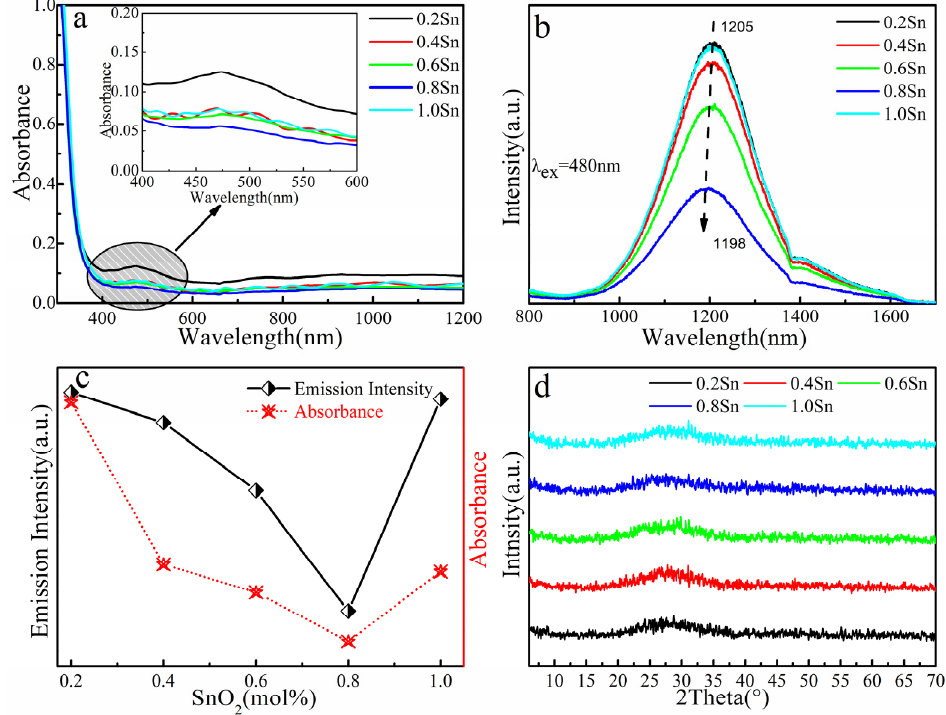
Figure 3. ( a ) Absorption spectra of (59.5-x) SiO 2 -10Al 2 O 3 -30CaO-0.5Bi 2 O 3 -xSnO 2 (x = 0.2, 0.4, 0.6, 0.8, 1.0) samples. The inset shows their absorbance in the range from 400 nm to 600 nm. ( b ) PL spectra of the (59.5-x) SiO 2 -10Al 2 O 3 -30CaO-0.5Bi 2 O 3 -xSnO 2 glass samples excited by a 480 nm LD. ( c ) Dependencies of emission intensity and absorption spectra on SnO 2 concentration. ( d ) XRD patterns of the (59.5-x) SiO 2 -10Al 2 O 3 -30CaO-0.5Bi 2 O 3 -xSnO 2